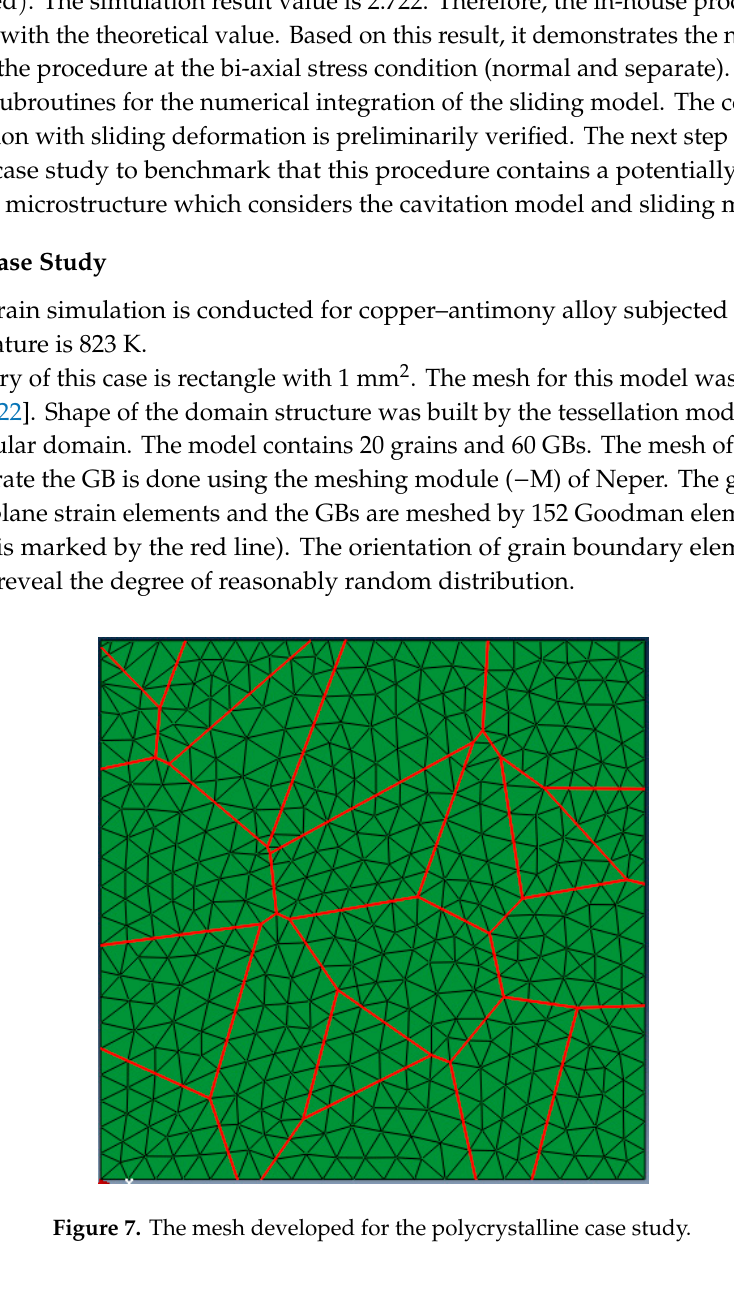
Figure 8. Orientation angle of the grain boundary element’s normal direction.